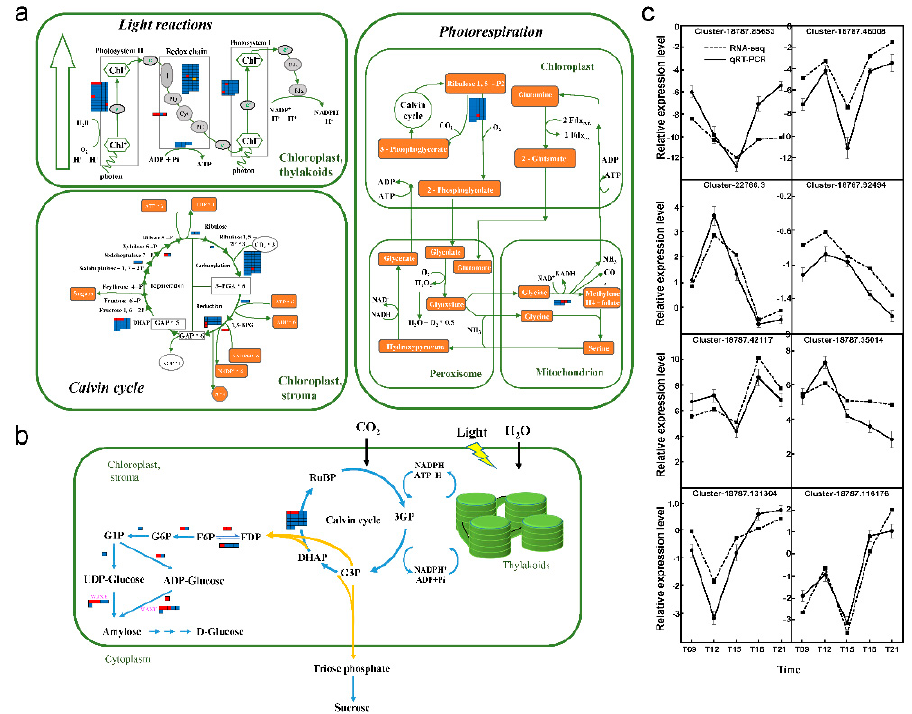
Figure 6. DEGs are involved in photosynthesis, carbon fixation, and starch biosynthesis. ( a ) Photosynthesis and carbon fixation pathway; ( b ) Starch biosynthesis pathway. The color of the rectangle represents the changes of gene expression under NaCl treatment, red indicates upregulated and blue indicates downregulated over the full-time series (09:00–21:00). The yellow represents DEGs with both differentially upregulated and downregulated expressions over the time series. FDP: beta-D-fructose 1, 6-bisphosphate, F6P: beta-D-fructose 6-phosphate, G6P: alpha-D-glucose 6-phosphate, G1P: D-glucose 1-phosphate. The details of gene annotation and expression changes are shown in Tables S13 and S14, respectively. ( c ) Verification and expression analysis of selected DEGs by quantitative real-time PCR (qRT-PCR). Data are presented as means ± SD (n = 3).